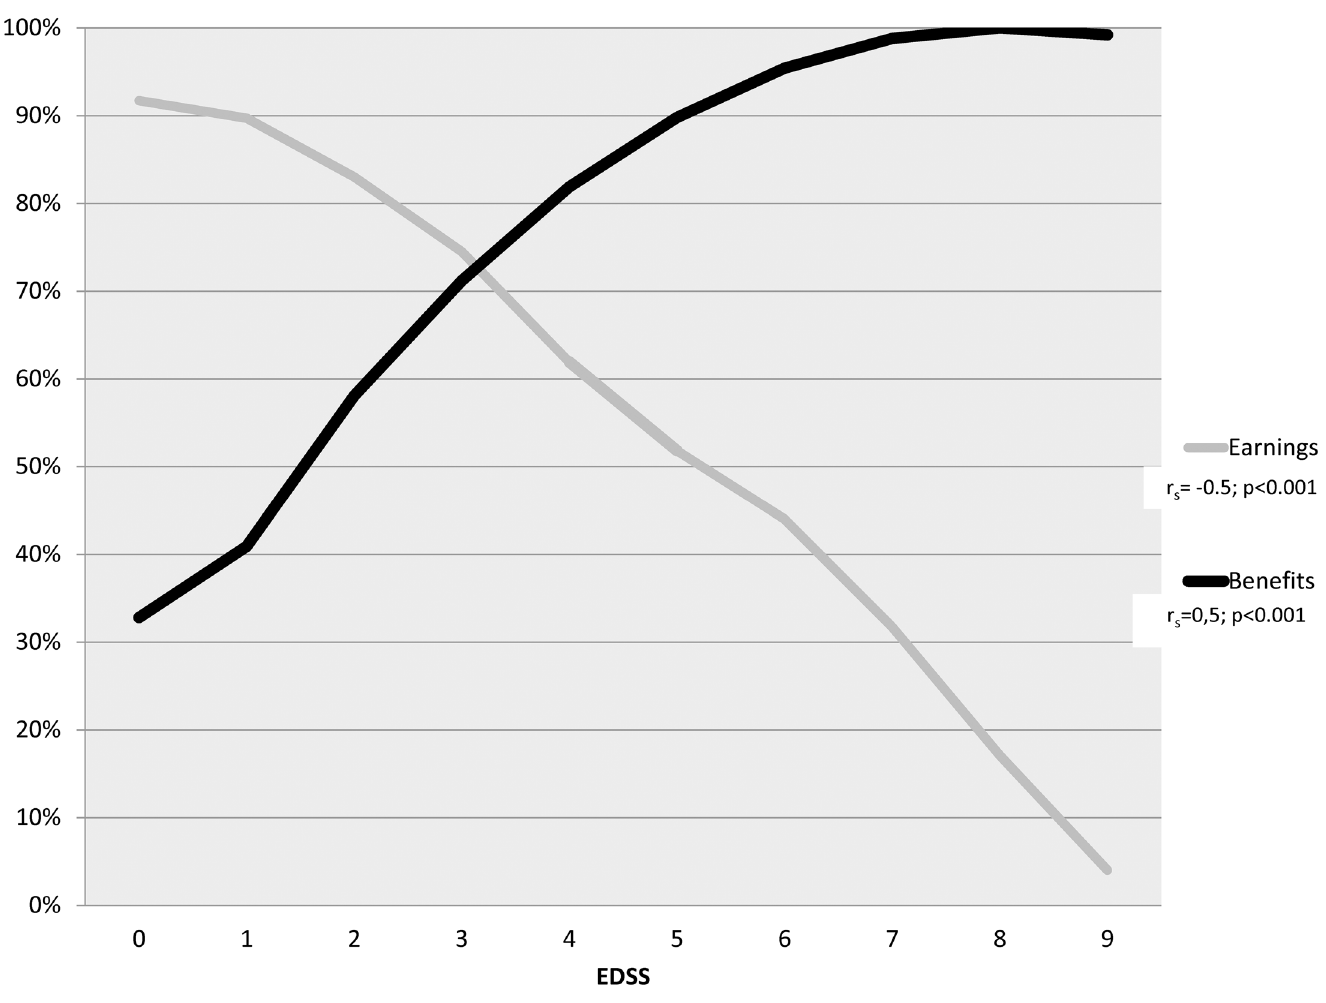
Fig 1. Percentages of MS patients who had earnings and got benefits, by different disability